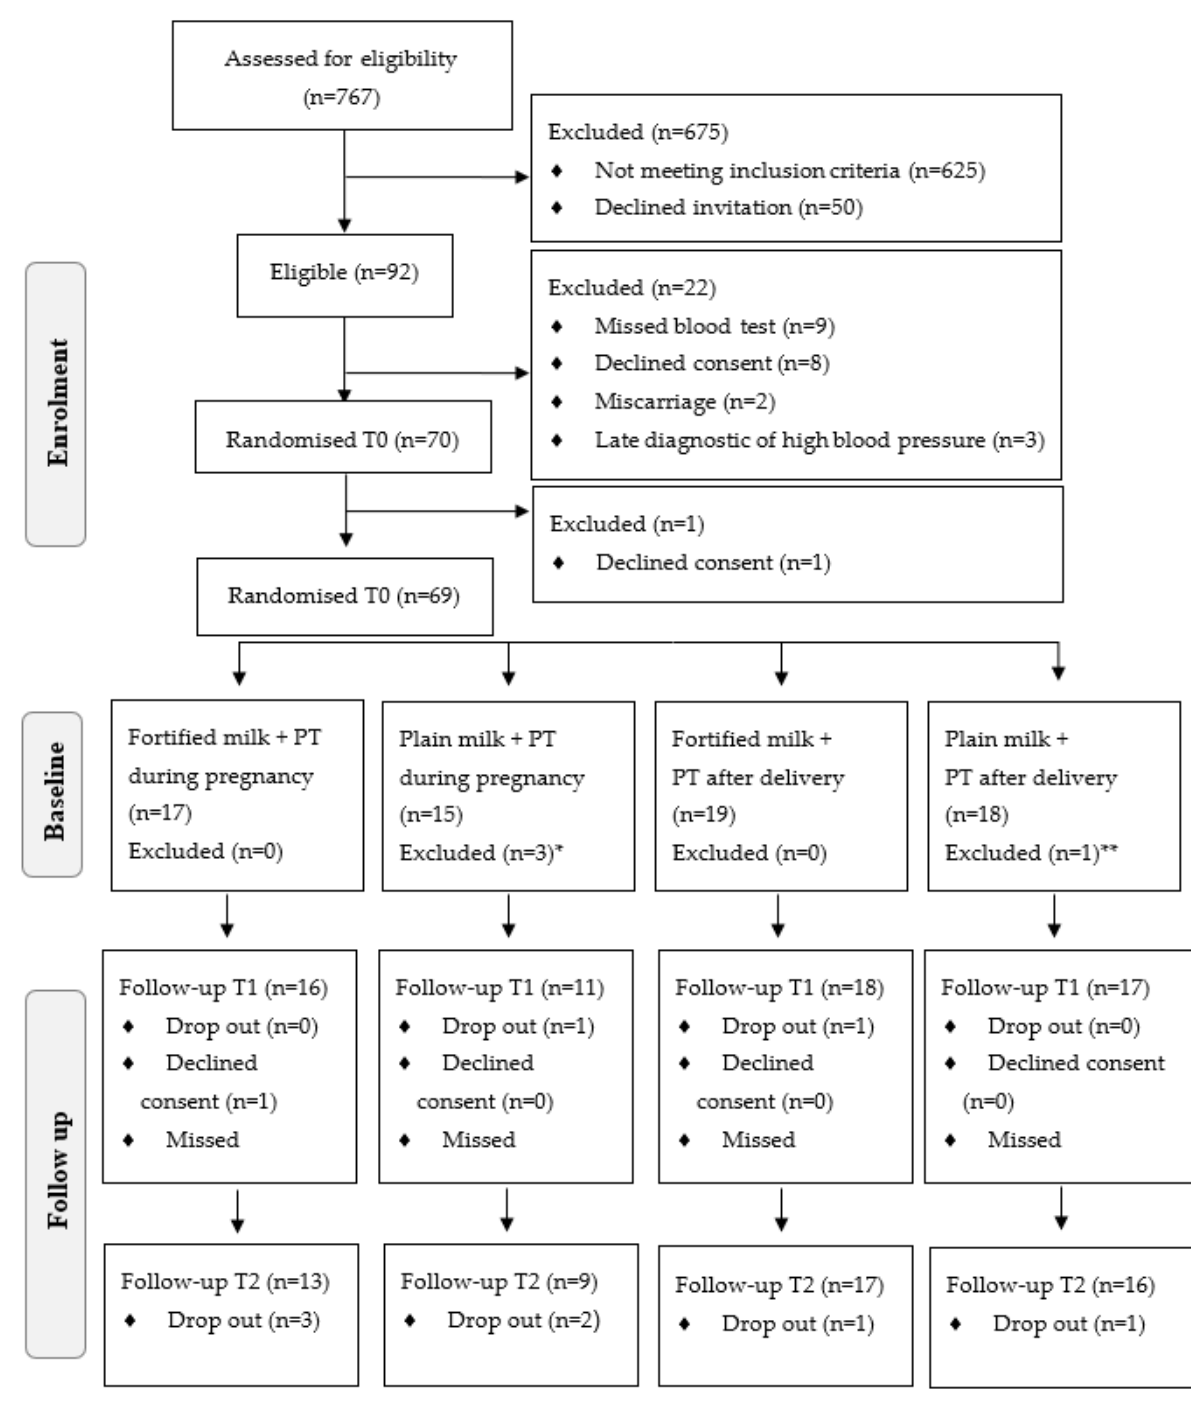
Figure 1. Study flowchart of enrolment, allocation, and follow-up of the pregnant women. PT: Periodontal treatment. * Did not start periodontal treatment ( n = 1) or milk consumption ( n = 1) or both ( n = 1). ** did not start milk consumption ( n = 1).